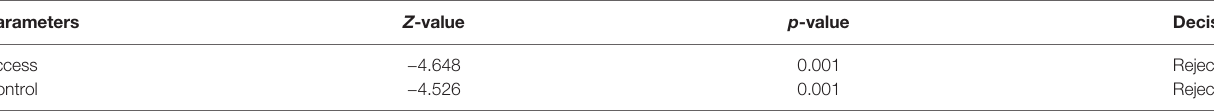
TABLE 4 | Access and control of men and women on